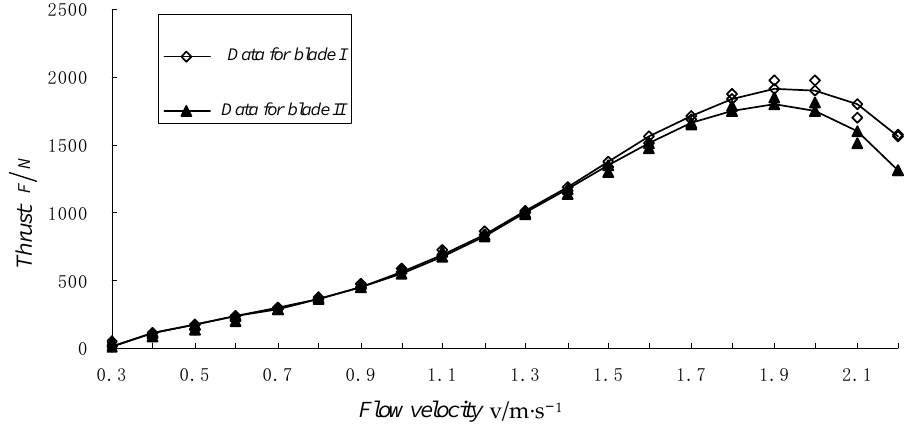
Figure 18. Thrust of the blade at di ff erent velocities.